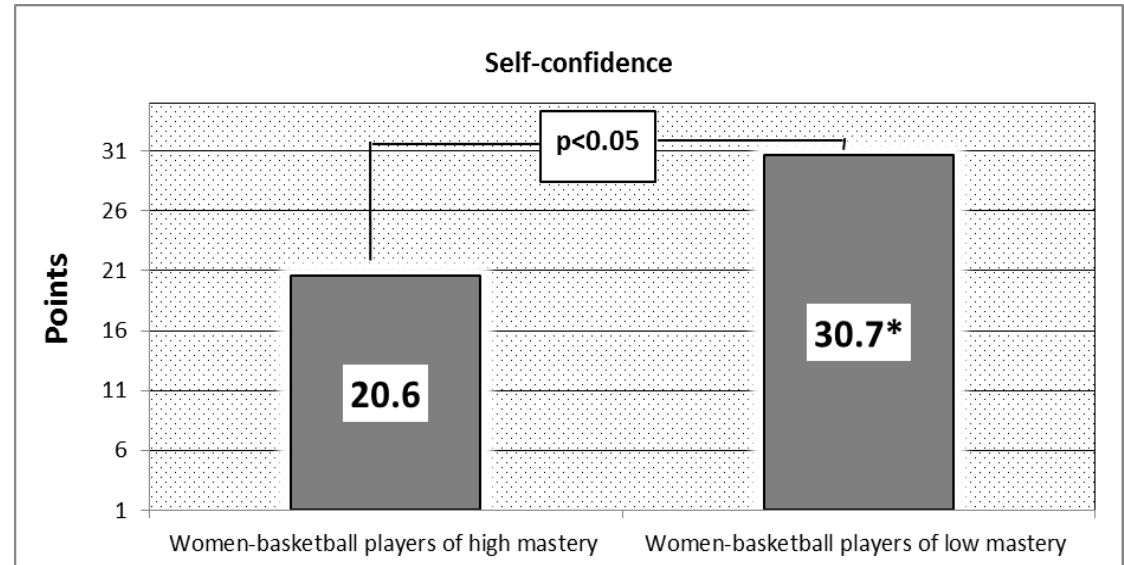
Fig.2. Distribution of s omatic anxiety indexes of women-basketball players of different mastery (in points) Note: * – marking of the statistically reliable difference